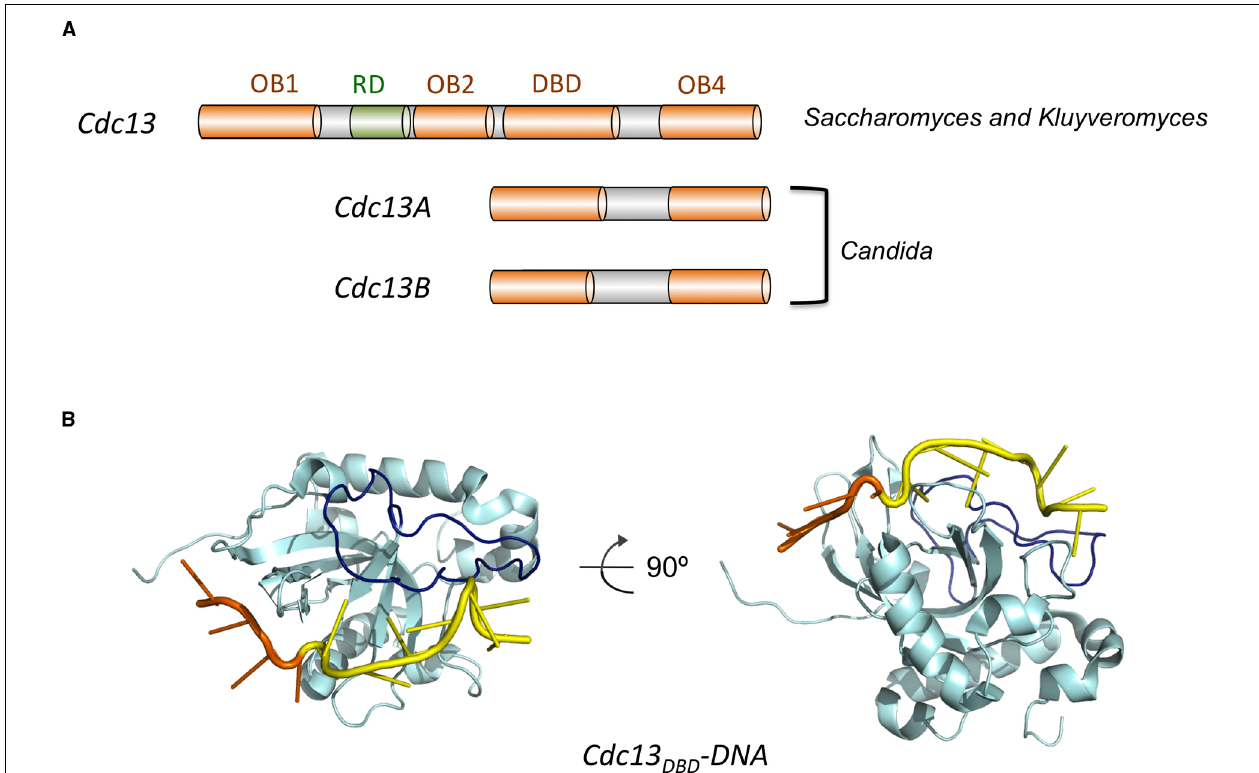
FIGURE 4 | The domain organization of Cdc13 and the structure of Cdc13 DBD -DNA complex. (A) The domain structures of Cdc13 homologs from various Saccharomycotina species are illustrated. The four OB folds (OB1, OB2, DBD, and OB4) are displayed in orange, and the RD (recruitment domain) is